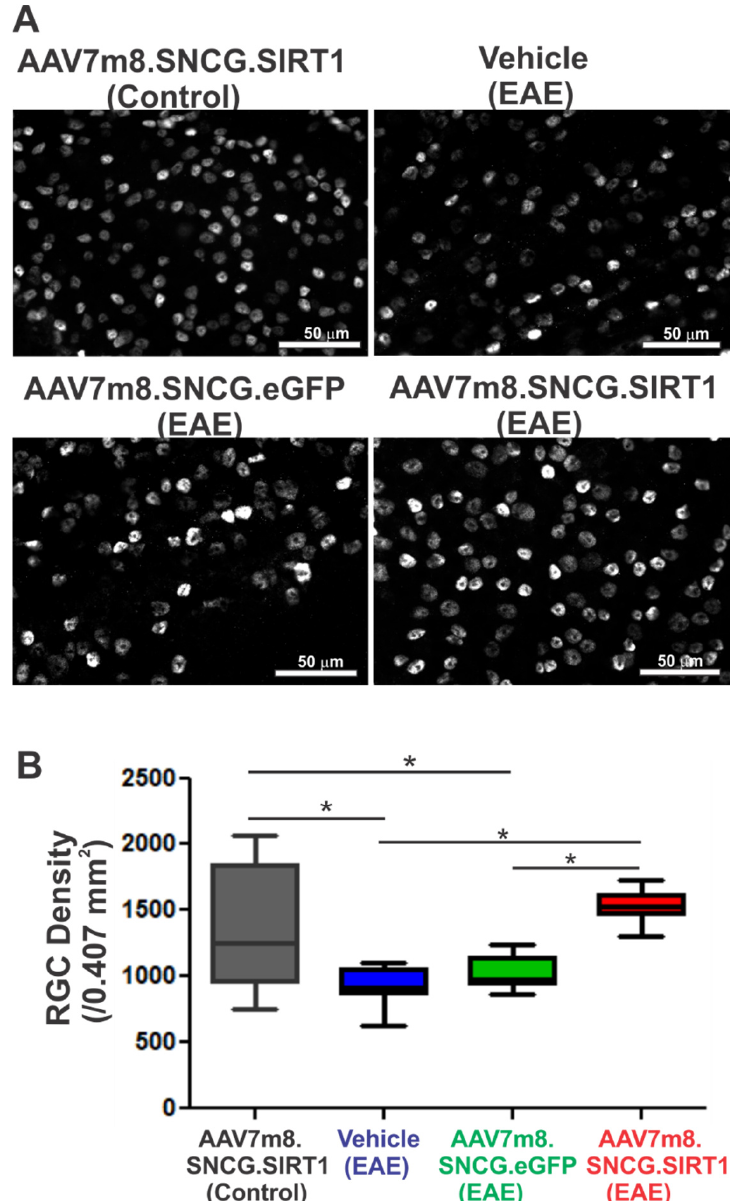
Figure 3. Effects of AAV7m8-mediated selective expression of SIRT1 in RGCs on RGC survival. ( A ) Representative immunofluorescence micrographs of RGC staining in the central retina of vehicle-, AAV7m8.SNCG.eGFP- and AAV7m8.SNCG.SIRT1-treated control and EAE mice. Scale bar, 50 μ m. ( B ) The total number of labeled RGCs present in 12 standardized retinal fields was determined. The average number of surviving RGCs per total sampled area of retina of control and EAE mice is shown in the graph. Values are means ± SEM. * p < 0.05 by one-way ANOVA and Tukey’s multiple comparisons test ( n = 13 for AAV7m8.SNCG.SIRT1 (control); n = 7 for vehicle (EAE); n = 8 for AAV7m8.SNCG.eGFP (EAE); n = 17 for AAV7m8.SNCG.SIRT1).